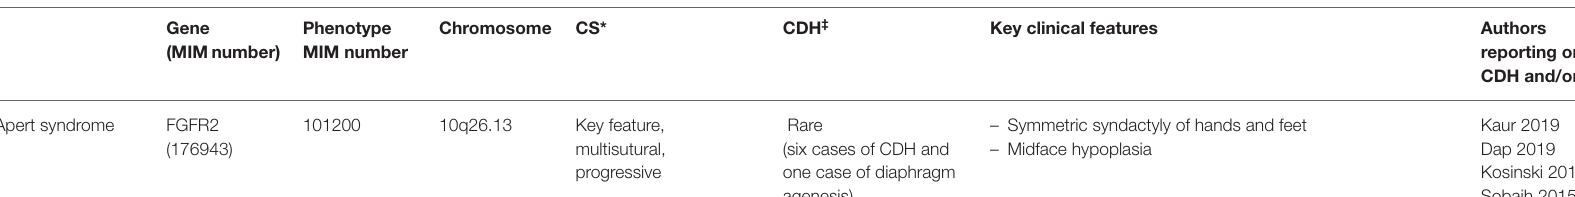
TABLE 2A | Overview of disorders characterized by co-occurrence of craniosynostosis and congenital diaphragmatic hernia. Clinical disorders with autosomal dominant inheritance